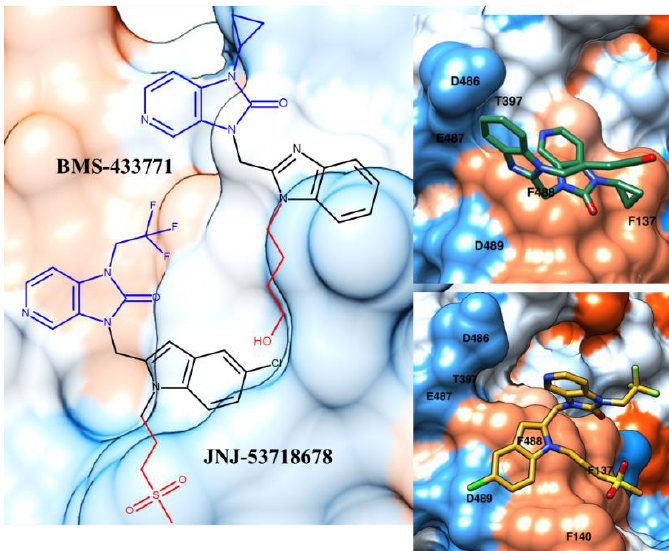
Figure 4. Chemical structure and X-ray positioning of BMS-433771 (pdb code: 5EA7) [31] and JNJ-53718678 (pdb code: 5KWW) [32] in complex with the RSV F protein. The chemical motifs of the two inhibitors featuring quite comparable contacts with the biological target are highlighted in blue and red. Hydrophobic and polar areas of the protein are represented as blue and orange regions on the RSV F protein’s Connolly surface.